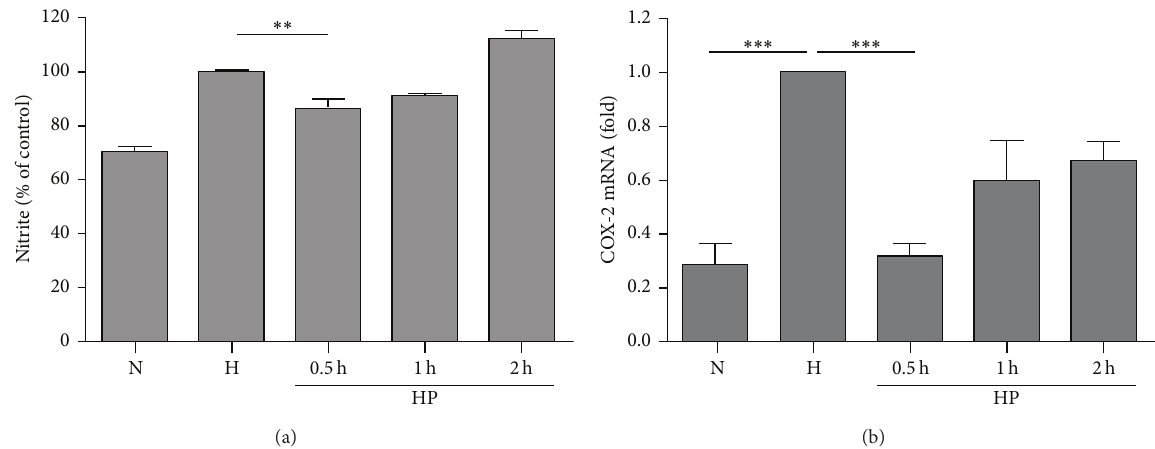
Figure 5: Hypoxia preconditioning suppresses prolonged hypoxia-induced inflammation in primary mixed glial culture. (a) Brief hypoxia exposure for 0.5 h before prolonged hypoxia damage (4h) significantly reduced the production of nitrite. ∗∗ 𝑃 < 0.01 compared with hypoxia control. (b) mRNA expression of cyclooxygenase-2 (COX-2) was also significantly suppressed by brief hypoxic preconditioning for 0.5 h. ∗∗∗ 𝑃 < 0.001 compared with normoxia and hypoxia control. ((a), (b)) The data represent the mean ± standard error of the mean (SEM), based on five independent experiments in each